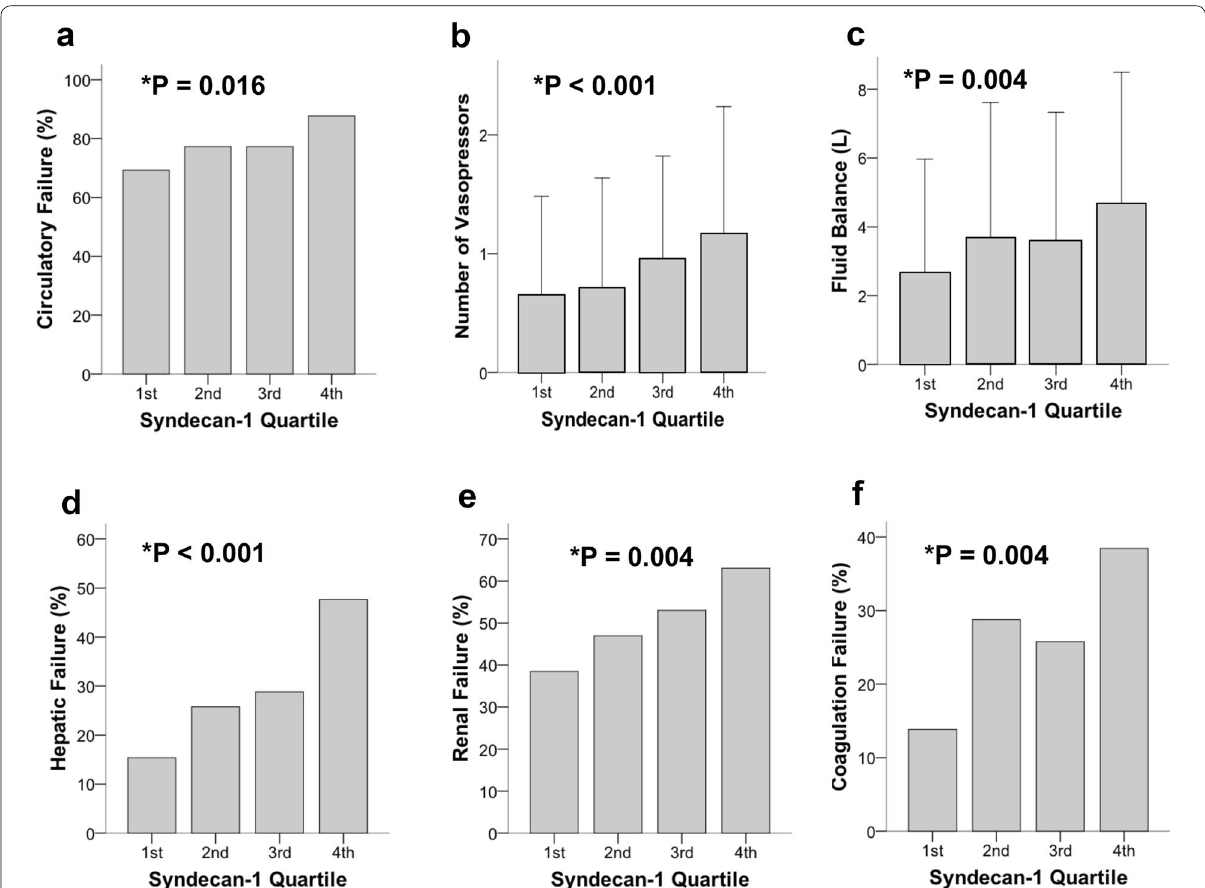
Fig. 3 Higher plasma syndecan-1 levels by quartile were associated with non-pulmonary organ dysfunction at enrollment including a circula- tory failure, b number of vasopressors, c fluid balance over the first 24 h, d hepatic failure, e renal failure, f coagulation failure. Organ failures were defined by Brussels organ failure scores at enrollment. p values by linear-by-linear association test except for number of vasopressors and fluid bal- ance which were analyzed by linear